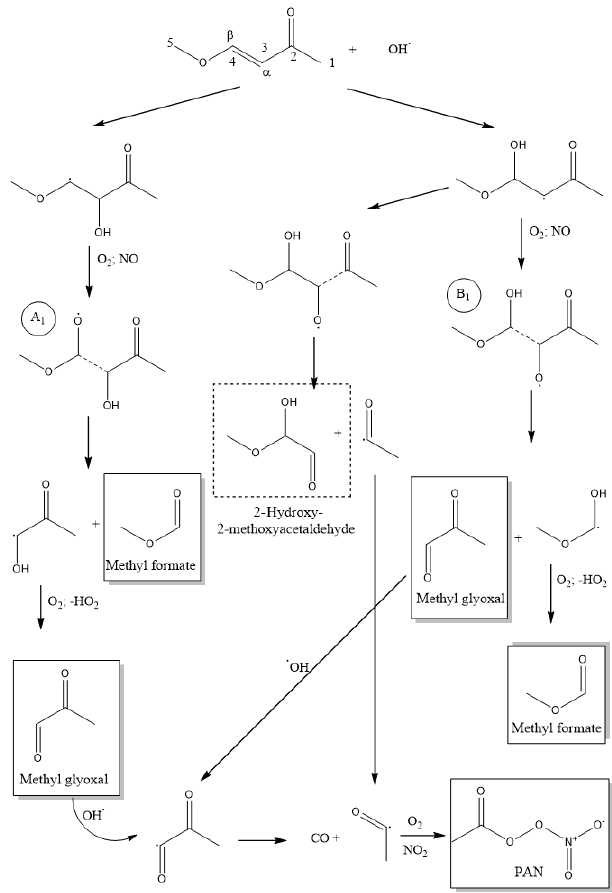
Scheme 1. Simplified reaction mechanism for the addition